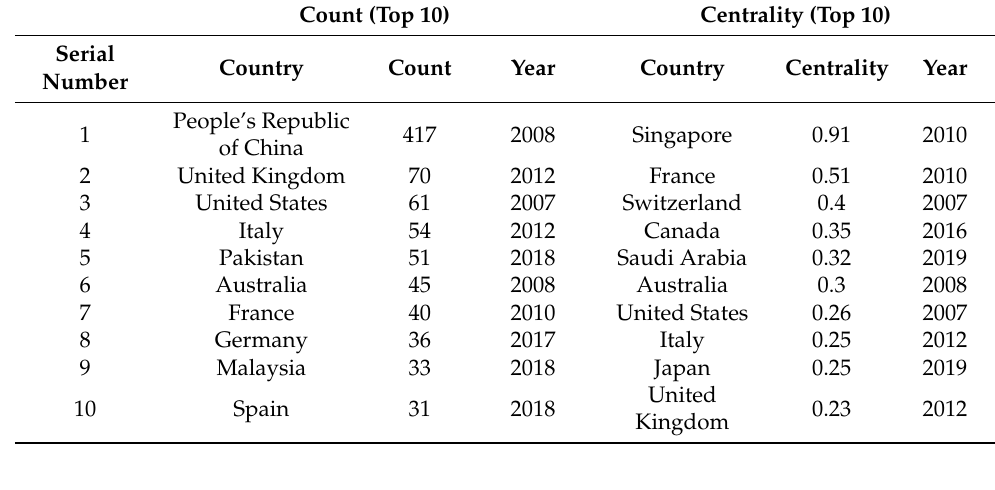
Table 3. Comparison of the number and centrality of national publications.